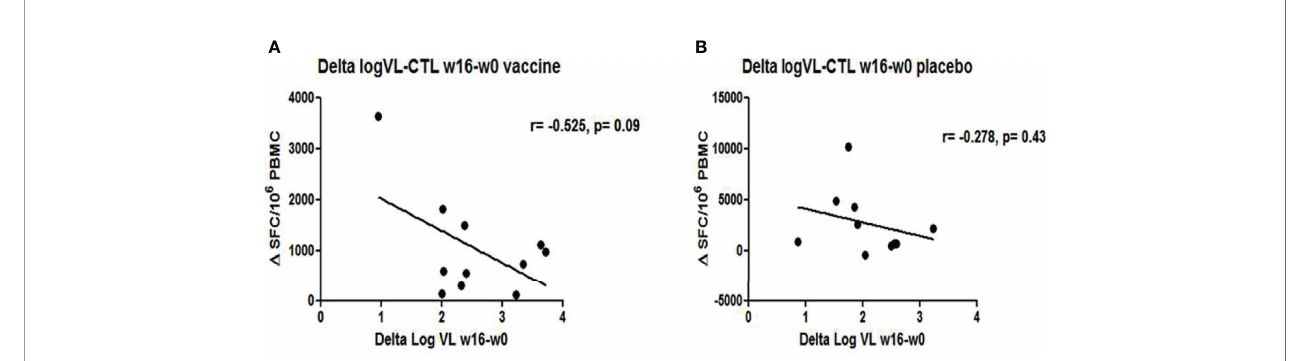
FIGURE 7 | Correlations between changes in VL and HIV-1-spec fi c T-cell responses at w16: Graphs represent the trend of inverse correlation between D VL and D HIV-1-speci fi c T cell responses (w16-w0) (A) in vaccine group (r=-0.525, p= 0.09) (B) whereas no correlation was observed in placebo group (r=-0.275,